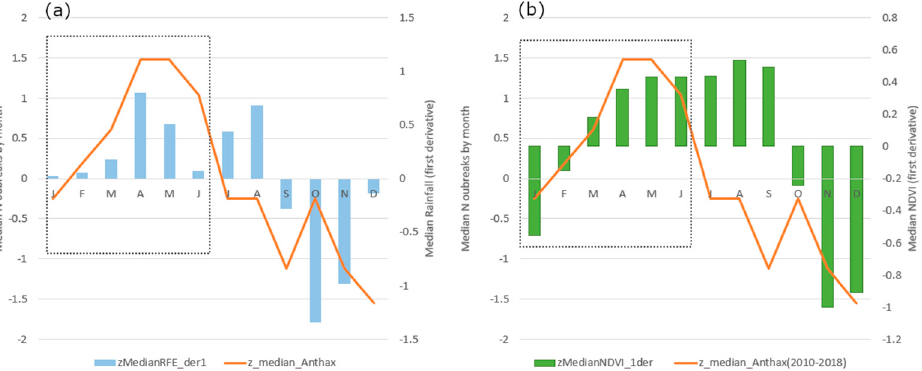
Figure 5. Standardized median number of anthrax outbreaks (orange line) against ( a ) first derivative of standardized median precipitation (blue bars) by month and ( b ) first derivative of standardized median NDVI (green bars) by month. The inset of each chart shows that the number of outbreaks increases with incremental change in precipitation and NDVI during January–June.